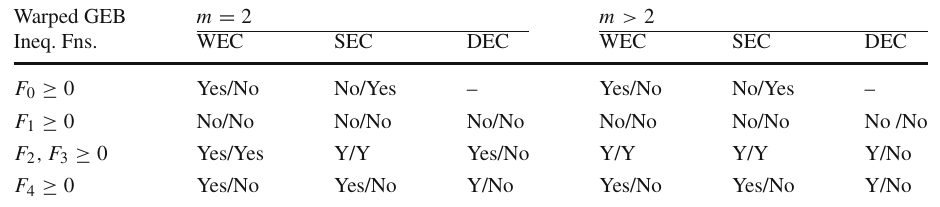
> 0 (where f ( y ) = − log [ cosh ( y ) ] ) for m = 2 , 4 and 8 4 Warped GEB m =